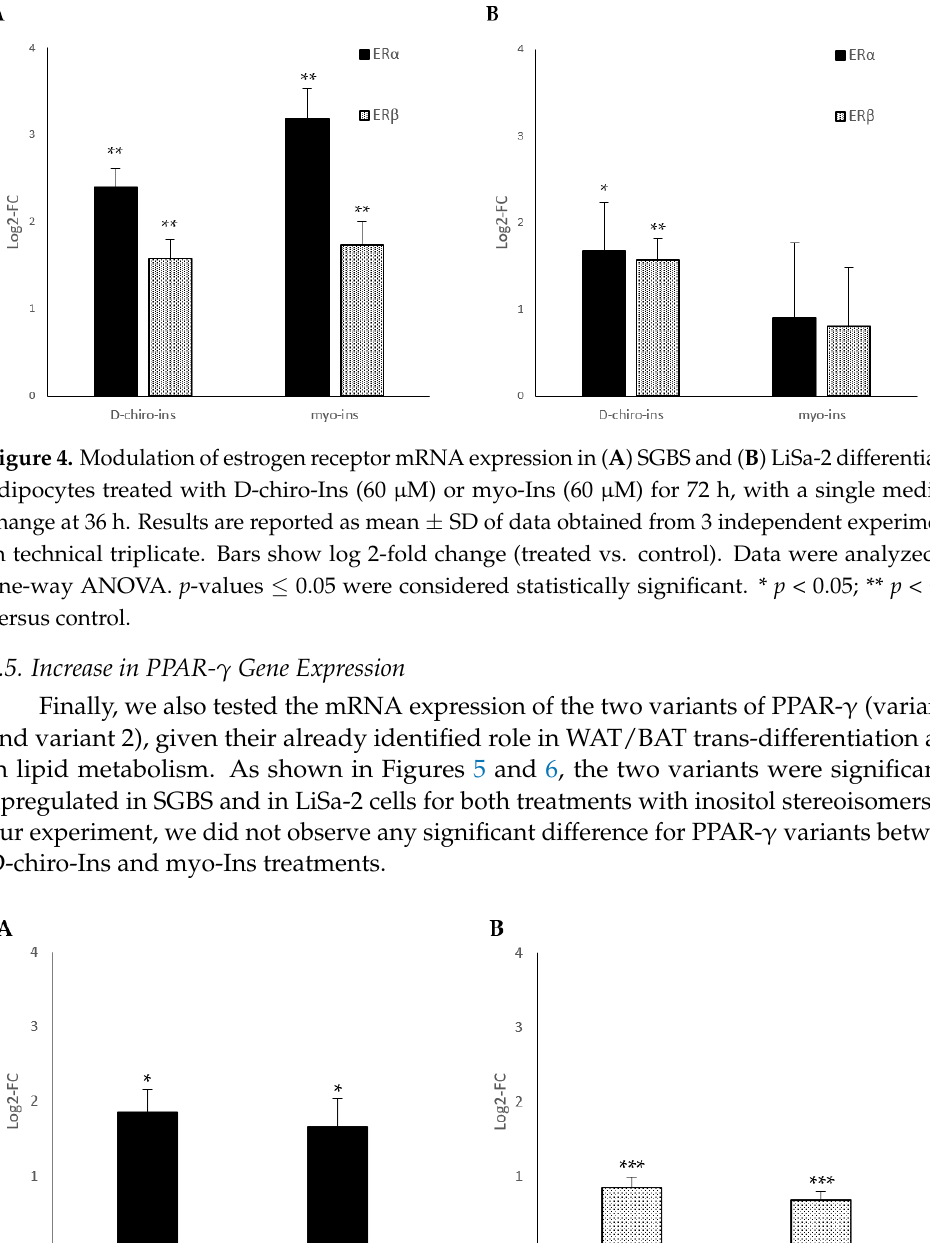
Figure 6. Modulation of the expression for the PPAR- γ variant 2 (PPAR- γ v2) messenger in ( A ) SGBS and ( B ) LiSa-2 adipocyte cells. D-chiro-Ins and myo-Ins concentrations used for the experiments were 60 µM. Results are reported as mean ± SD of data obtained from 3 independent experiments in technical triplicate. Bars show log 2-fold change (treated vs. control). Data were analyzed by one- way ANOVA with repeated measures followed Duncan–Waller post hoc test. p -values ≤ 0.05 were considered statistically signi fi cant. * p < 0.05 versus control; ** p < 0.01 versus control. 3. Discussion In our experiments, we demonstrated that D-chiro-Ins and myo-Ins induce WAT/BAT trans-di ff erentiation in the two principal adipocyte human cell models: SGBS and LiSa-2. SGBS cells are non-immortalized pre-adipocytes isolated by subcutaneous fat tissue, whereas LiSa-2 is a liposarcoma of visceral fat. Both cell models are able to trans- di ff erentiate with speci fi c external stimuli. A fundamental aspect of BAT/beige regulation is the stimulation of UCP-1 [20]. UCP- 1 is expressed only in brown/beige adipocytes. It increases the proton conductance in the inner mitochondrial membrane of these speci fi c adipocytes, thus determining the uncoupling of the respiratory chain and the production of heat. This action of UCP-1 in BAT is the main molecular basis for thermogenesis in homeothermic mammals in response to exposure to cold and diet [21]. In our experiments, D-chiro-Ins treatment induced an increase in UCP-1 mRNA levels in both cell lines (visceral and subcutaneous adipose tissue), while for myo-Ins, a signi fi cant positive modulation was detected only in visceral adipose tissue cells (LiSa-2), showing a di ff erentiation of adipocyte towards BAT- type characteristics. These results were con fi rmed by the increase in mitochondrial DNA